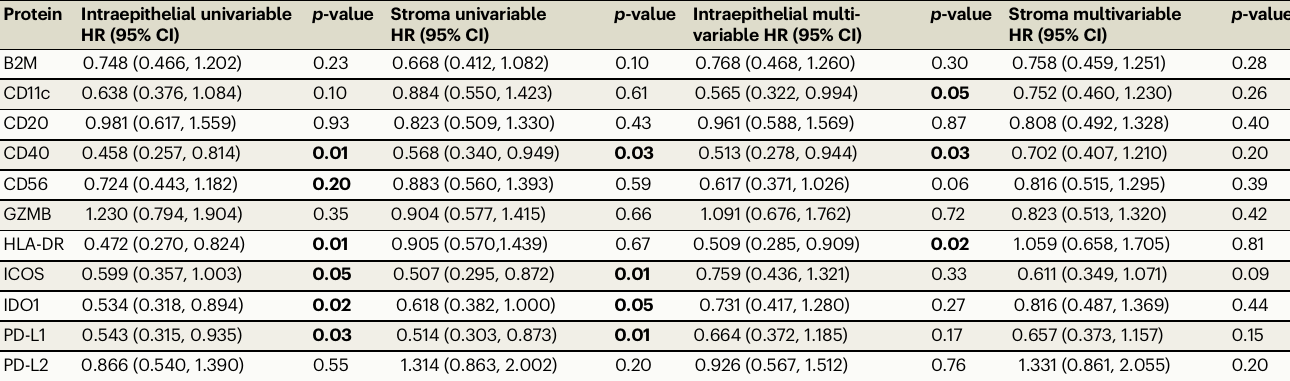
Table 3 | Cox hazard ratios (HRs) for recurrence in Mayo Clinic TNBC_TMA samples Protein Intraepithelial univariable HR (95%